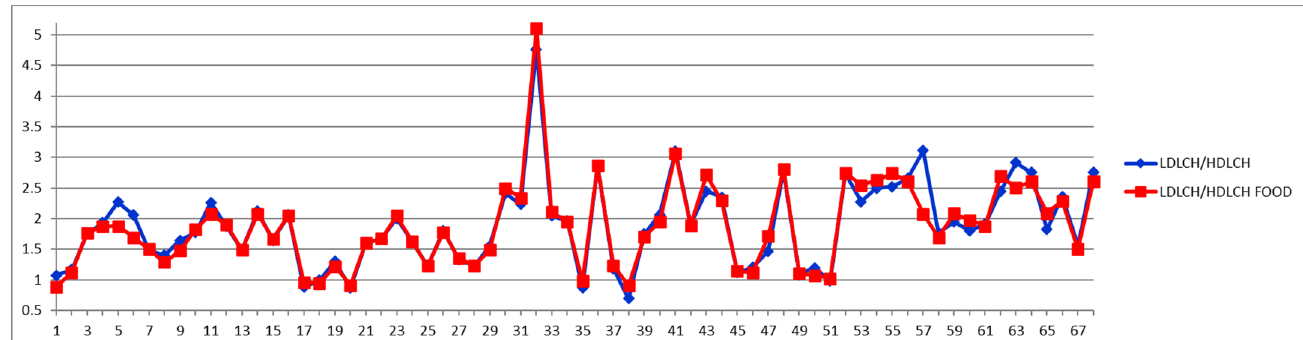
Figure 12. The food intake effect on LDL/HDL cholesterol ratios as difference between postprandial and fasting concentrations as percentage relative to fasting concentration.